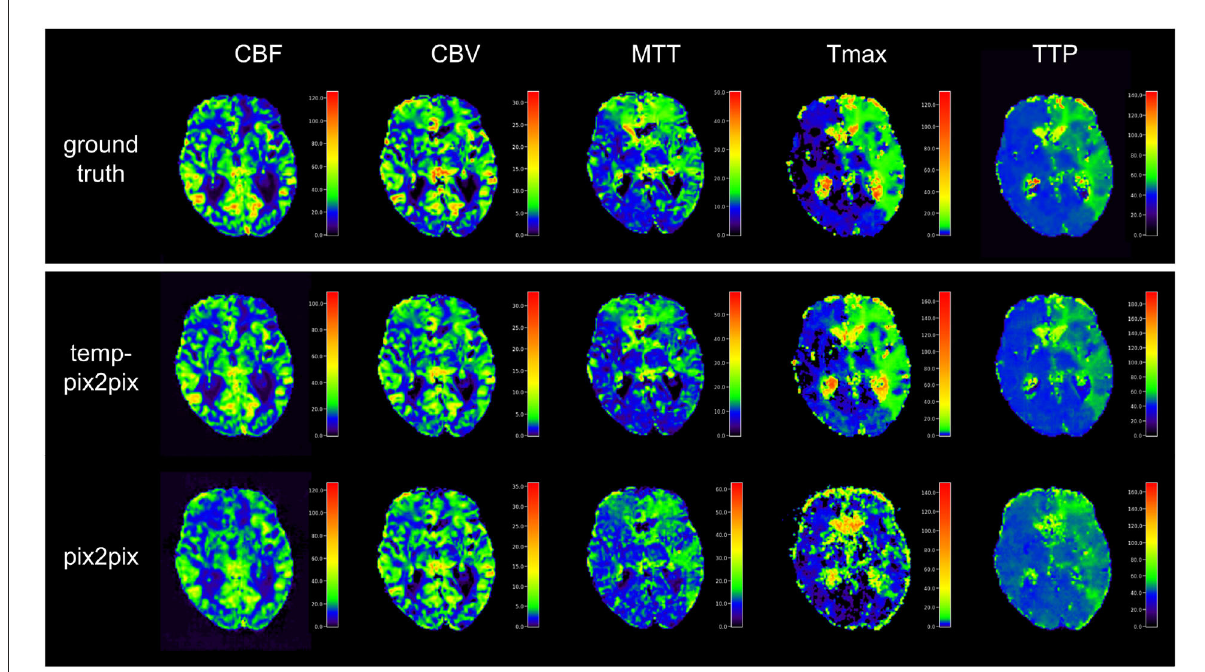
FIGURE4 Synthesized perfusion parameter maps (middle, bottom rows) compared with the ground truth reviewed by an expert (top row) for one representative patient showing average performances from the acute stroke test dataset. The perfusion parameter maps generated by the temp-pix2pix all look similar to the ground truth, whereas the time-dependent parameters (Tmax and TTP) are not well captured by the pix2pix